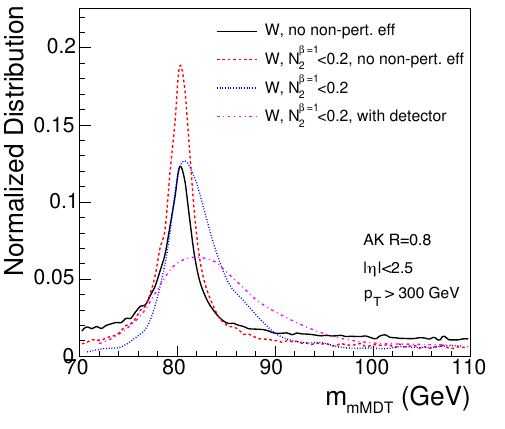
Figure 7 . Dependence of the W jet mass distribution on non-perturbative corrections, N (cid:12) =1 selection and detector